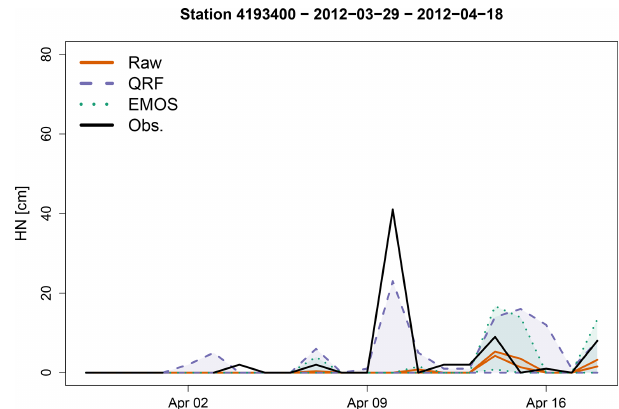
Figure 4. Time series of the raw reforecasts for a 1d lead time (orange plain lines) and predictive quantiles using QRFs (purple dashed lines) and EMOS (green dotted lines) during April 2012 for the station 4193400. For each of the three prediction systems, the lower and upper curves represent the 10th and 90th percentiles, re- spectively. The solid black line represents the time series of the HN